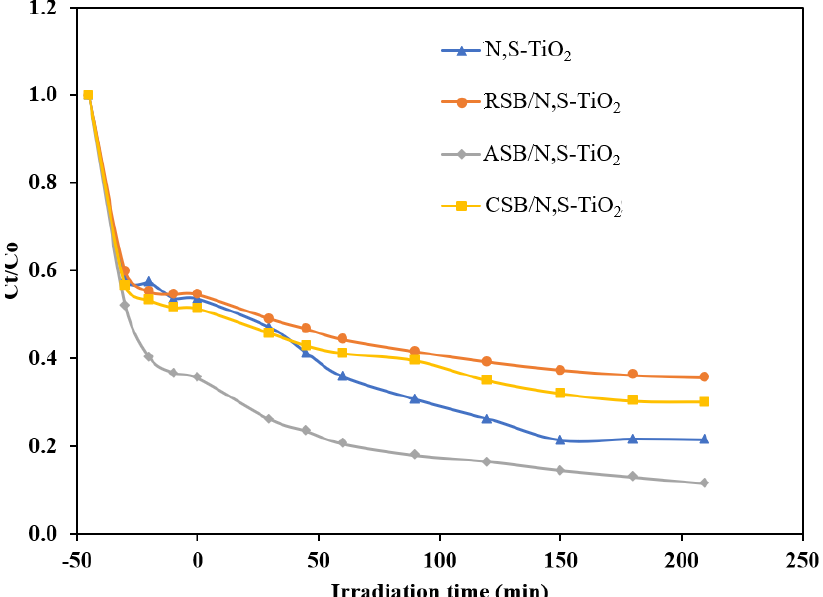
Figure 5. Adsorption reaction and photocatalytic degradation of CIP of N,S-TiO 2 and three composite materials(condition: pH = 5.5–6, [CIP] 0 = 30 ppm, dosage = 0.05 mg).